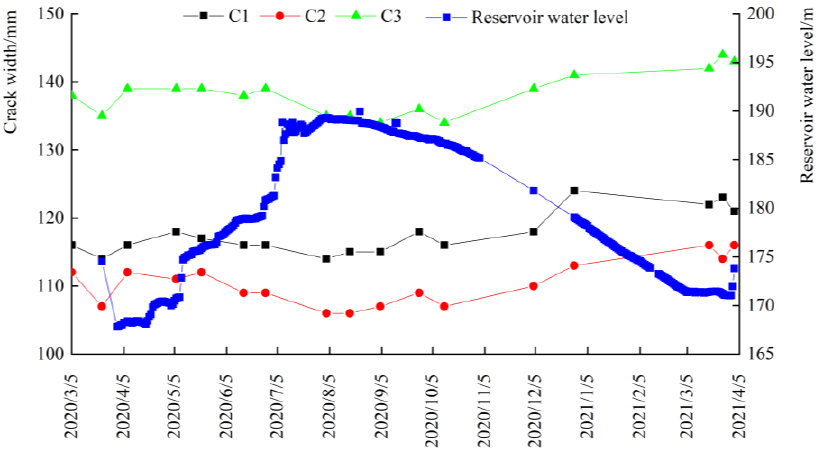
Figure 15. Time history curve of crack width and reservoir water level.